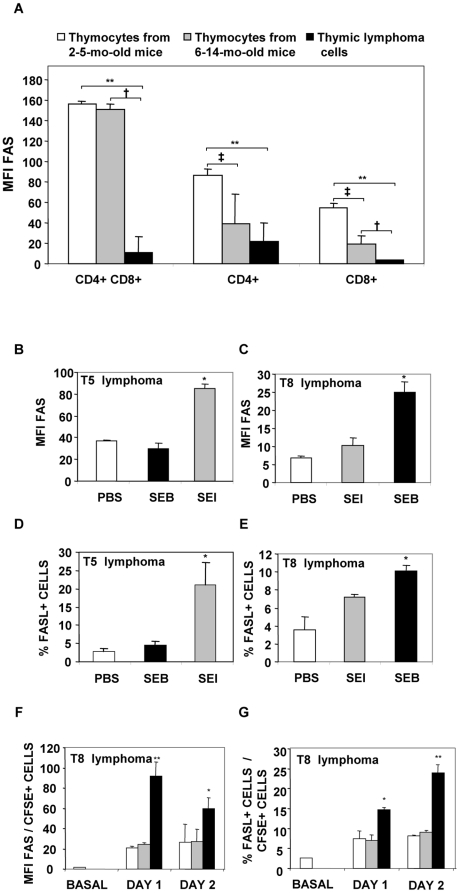
Sags induce increases in the level of expression of Fas and in the percentage of Fas-L+ cells in lymphoma T cells.Lymphoma T cells display low levels of Fas expression. (A) Single cell suspensions from thymus from 2-5-mo-old animals (n = 8), 6-14-mo-old animals (n = 11) and spontaneous AKR/J thymic lymphomas (n = 28) were stained with anti-CD4, anti-CD8 and anti-Fas MoAbs. Data show the mean fluorescence intensity (MFI) of Fas in each group. Data are expressed as the mean ± SD. **p<0.01, † p<0.05, ‡ p<0.05. (B, C, D, E) 2.5×105 T5 or T8 lymphoma cells were co-cultured with 0.7×105 intraperitoneal macrophages and treated with 10 µg/ml of SEI, SEB or PBS. At day 3, cells were harvested and stained with anti-Fas or anti-FasL MoAbs. (B, C) MFI of Fas, (D, E) percentage of FasL+ cells. Data are expressed as the mean ± SD. *p<0.05. (F, G) AKR/J mice were intraperitoneally inoculated with 5×106 T8 CFSE- labeled cells and intraperitoneally injected with 25 µg of SEE (grey bar), SEB (black bar) or PBS (white bar). At days 1 and 2 cells were recovered, stained with anti-Fas or anti-FasL MoAbs and analyzed by FACS. Data are expressed as the mean ± SD, n = 4 per group. **p<0.01, *p<0.05. All the experiments were performed three times with similar results.